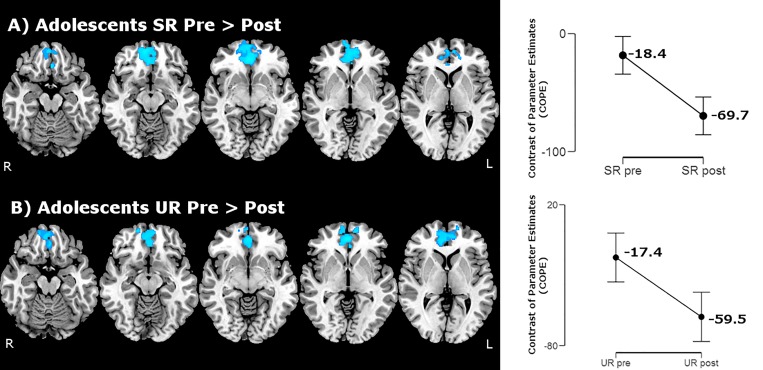
Within-group activation maps for adolescents showing changing in the activation patterns after the training.A) SR contrast and B) UR' contrast. Clusters in light blue indicate decreased activation after the training in the adolescents’ group. Axial images are in radiological orientation.